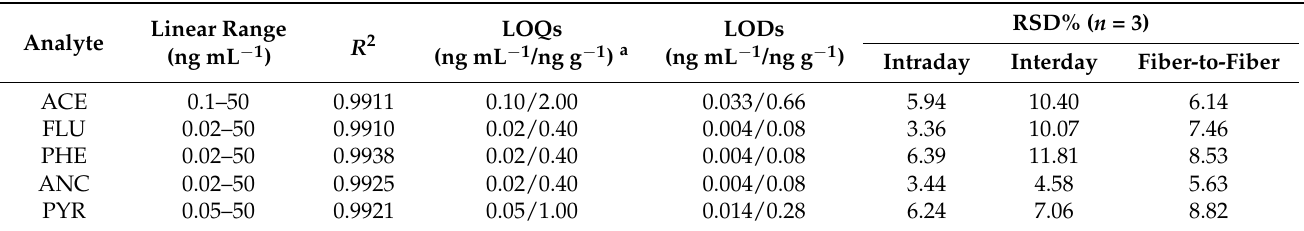
Table 1. Related analytical parameters of the developed SPME-GC-FID by using h-BN as fiber coating material for determination of PAHs.